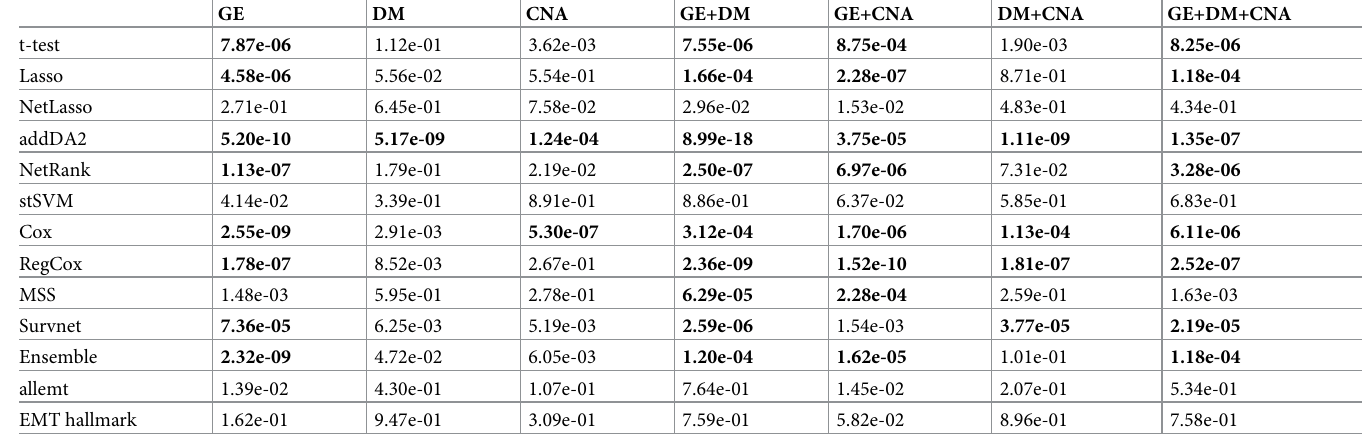
Table 6. The results of log-rank tests on stratified sample clusters using single- and multi-omics EMT signatures on all-stage samples. K-means algorithm was employed for clustering the samples into 3 groups. We highlighted all p-values that are lower than 10e-3. GE DM CNA GE+DM GE+CNA